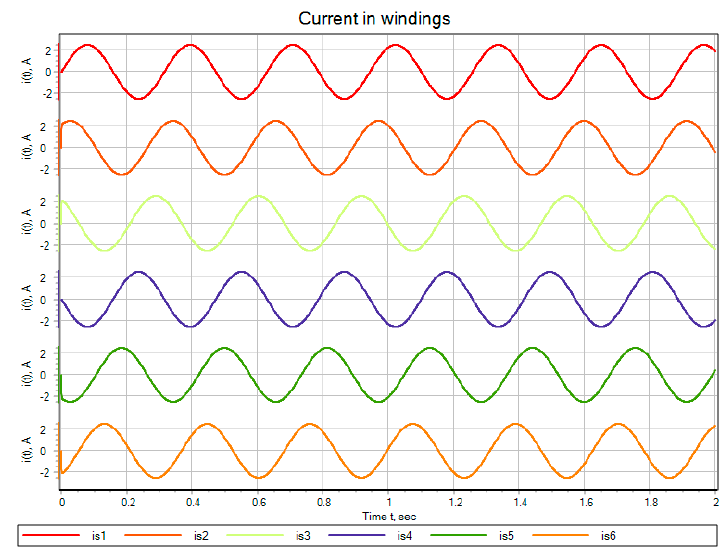
Figure 24. Current flowing in the generator windings.